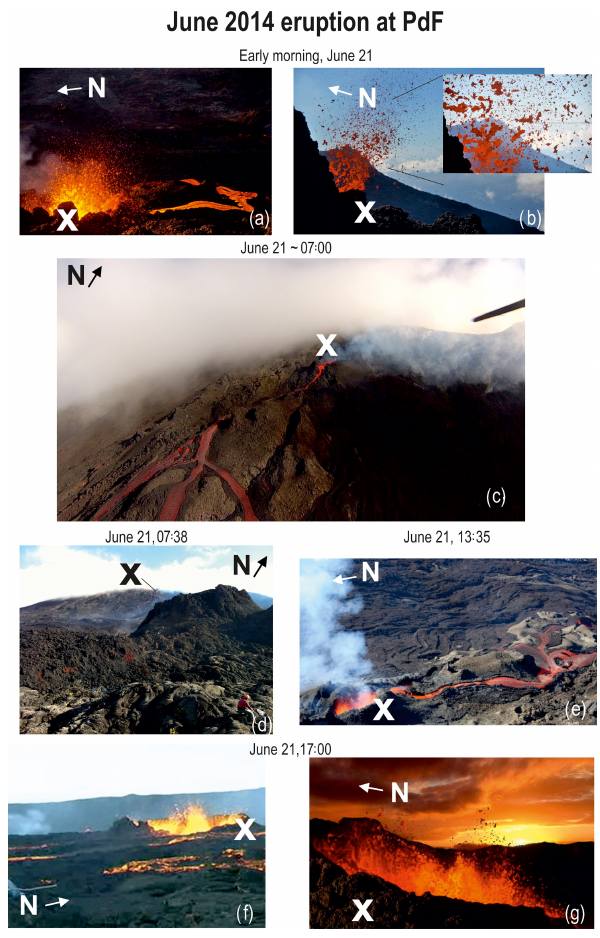
Figure 2. Photo collection from the 2014 eruption at the MV, high- lighted with a white cross (see location in Fig. 1). From (a) to (g) : evolution of the Strombolian activity from early morning to evening 21 June showing a decline in the activity with time. Unfortunately, the relatively more energetic Hawaiian fountaining events that happened during the night were not documented. (a) Strombolian activity at the MV and associated lava flow; (b) enlarged view of the Strombolian activity at the MV. The images in (a) , (b) , and the inset in (b) are from Laurent Perrier; (c) aerial view of the SE flank of PdF, taken by the OVPF team from the helicopter of the gendarmerie of La Réunion; (d) eastern front of the lava where the OVPF team collected a quenched lava sample; (e) low Strombolian activity at the MV and the associated lava flow; photo from http://www.ipreunion.com/volcan/reportage/2014/06/21/eruption- du-piton-de-la-fournaise-actualise-a-17h-la-lave-coule-sur- 1-5- kilometre,26023.html. Panels (f) and (g) show the decline of the Strombolian activity at the MV. The photo in (e) is from http://www.zinfos974.com/ L-eruption-du-Piton-de-la-Fournaise-Le-point-de17h_a72981. html and the photo in (f) is from (f) http://nancyroc.com/